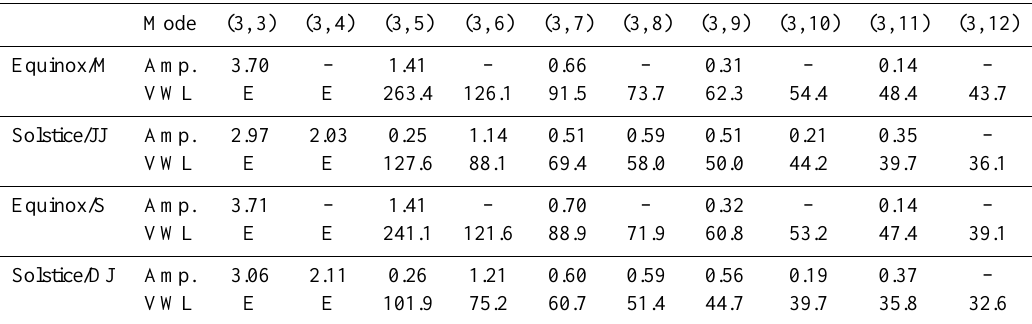
Table 1c. The amplitudes (Amp.) (Kday − 1 ) and the global averaged vertical wavelength (VWL) (km) of the terdiurnal heating Hough modes near the peak ( ∼ 52km) at 4